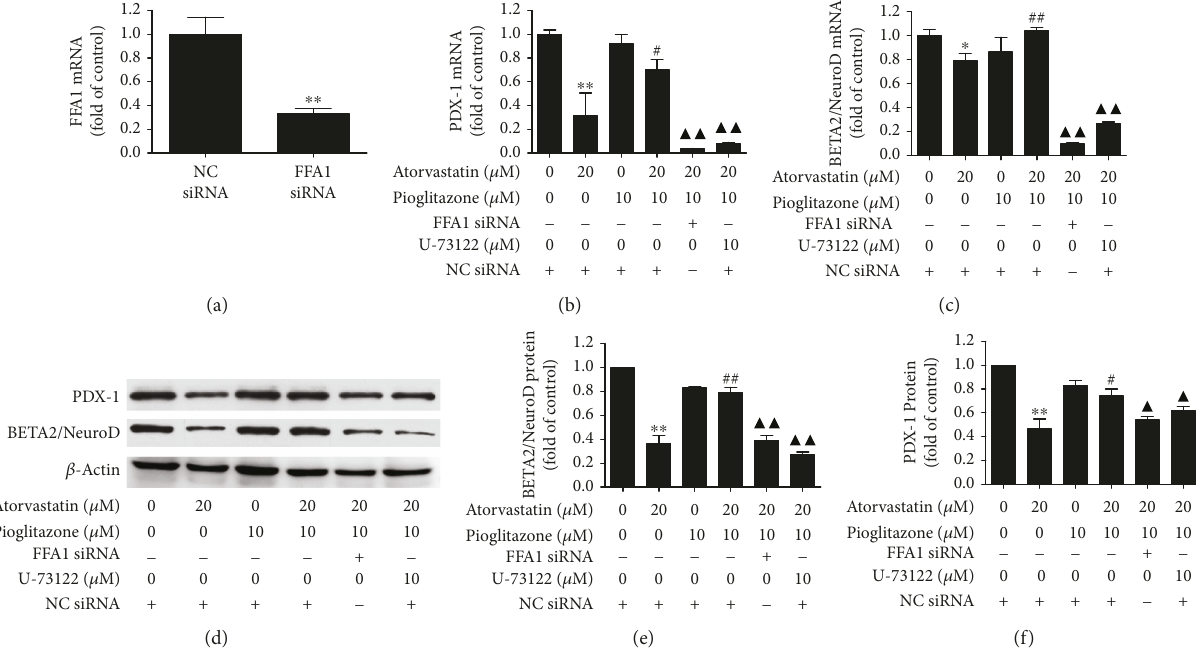
Figure 5: E ff ect of atorvastatin, pioglitazone, and FFA1-PLC signaling pathway inhibitors on the expression of PDX-1 and BETA2/NeuroD in INS-1 cells. (a) The expression of FFA1 mRNA was inhibited in rat FFA1 siRNA-transfected cells. (b and c) Administration of 10 μ M pioglitazone enhanced the mRNA expression of PDX-1 and BETA2/NeuroD reduced by 20 μ M atorvastatin in INS-1 cells, and the enhancement was suppressed by knockdown of FFA1 using siRNA or the PLC inhibitor U-73122 in INS-1 cells. (d, e, and f) Administration of 10 μ M pioglitazone enhanced the protein expression of PDX-1 and BETA2/NeuroD reduced by 20 μ M atorvastatin, and the enhancement was abolished by FFA1 siRNA and U-73122 in INS-1 cells. Negative control siRNA (NC-siRNA) was used for cell transfection as negative control to rule out any nonspeci fi c e ff ects that the siRNA transfection might have on cell function. β -Actin was detected as control. Each experiment was repeated at least three times. ∗ P < 0 05 and ∗∗ P < 0 01 compared to negative control. # P < 0 05 and ## P < 0 01 compared to 20 μ M atorvastatin treatment alone. ▲ P < 0 05 and ▲▲ P < 0 01 compared to 20 μ M atorvastatin and 10 μ M pioglitazone treatment